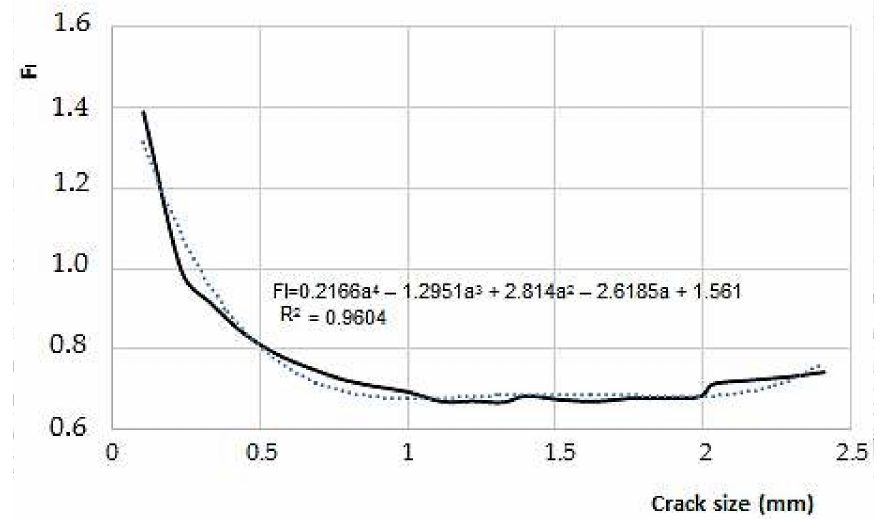
Figure 13. Behavior of F I as a function of the crack depth (for an over thickness of 3